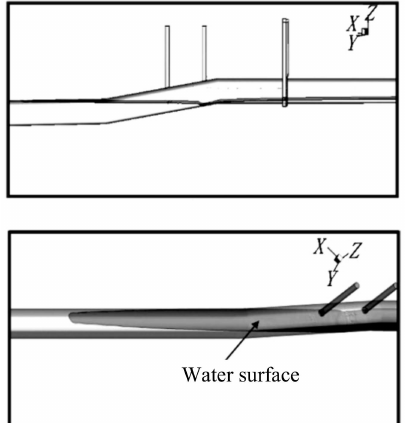
Figure 15. Water flow regime in the tailrace and diversion combined tunnel under flow break